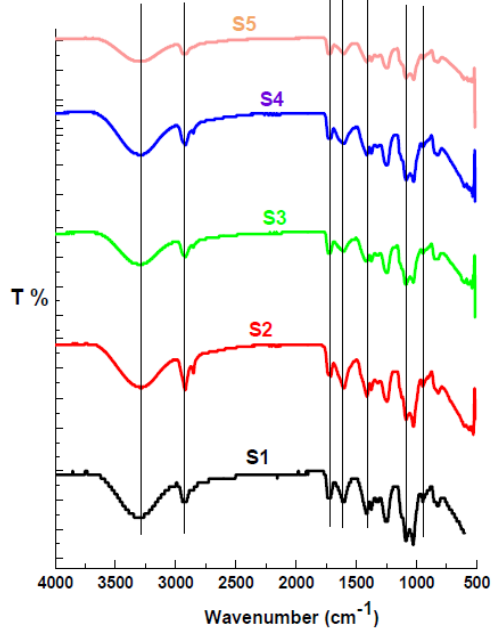
Figure 2. FTIR spectra of the MOE/SA/PVA.